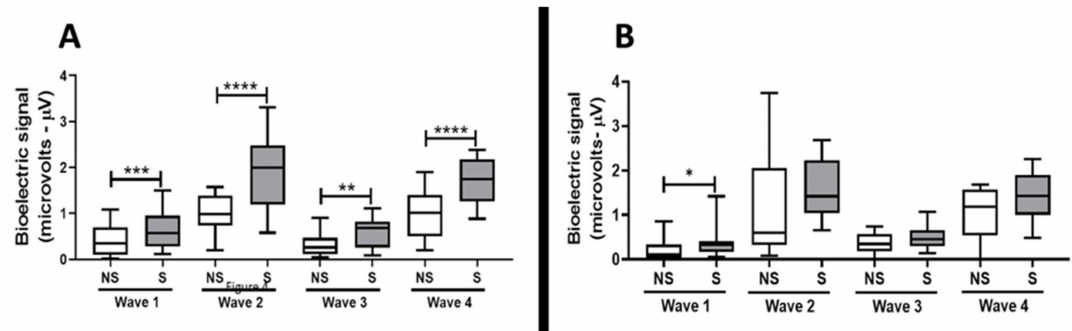
Figure 6. Auditory brainstem response (ABR), evaluated by waves amplitude I, II, III, and IV (represented by bioelectric signals set at microvolts, µ V) at 90 dBSPL ( A ) and at 80 dBSPL ( B ) in ears previously submitted (S, n = 20) or not submitted (NS, scramble, n = 20) to TNF α blockade by gene silencing and after to noise exposure. Di ff erences in the wave’s amplitude were evaluated by Student’s t -test with Bonferroni´s post-hoc test. The significance level was set as 5%. * p < 0.05, ** p < 0.01, *** p < 0.001, **** p <